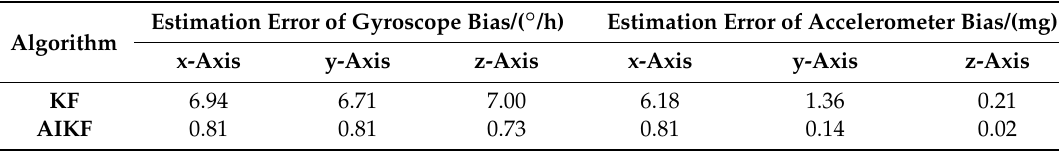
Table 4. Main functional specification of MEMS gyroscope. Table 3. Bias estimation result of two algorithms.